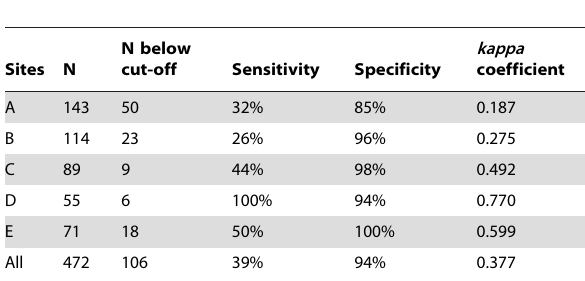
Table 7. Clinical agreement between PointCare NOW and Reference method at 2006 WHO guidelines for